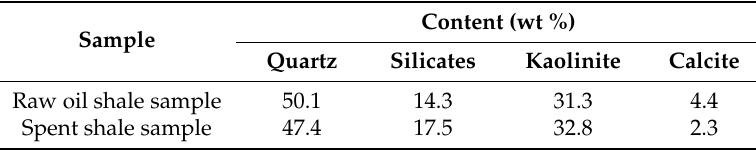
Figure 5. XRD patterns of raw sample and spent sample extracted by sub-critical water at 350 ◦ C for 150 h. Table 2. Mineral content of raw oil shale and spent shale